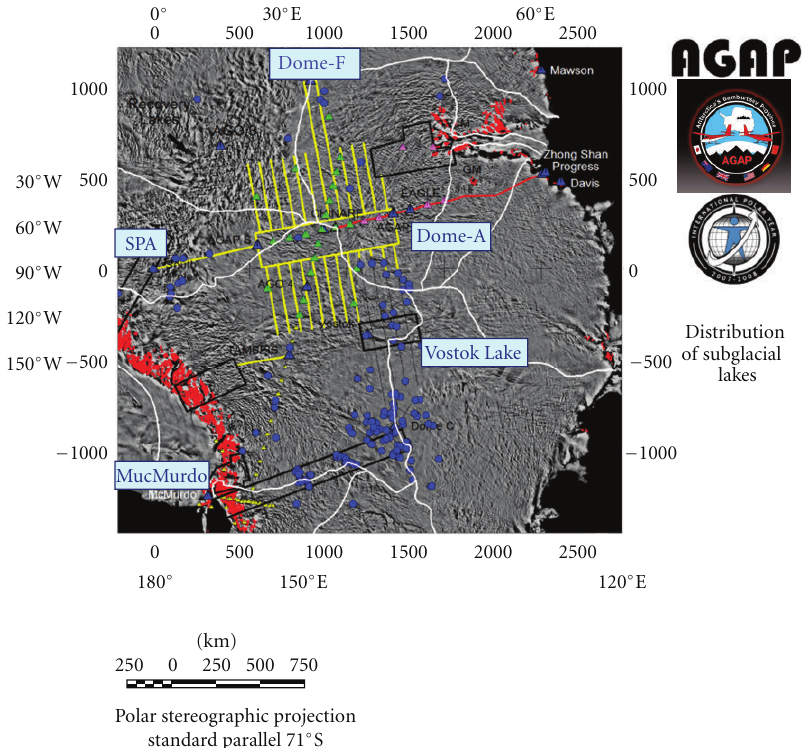
Figure 19: Distribution of subglacial lakes (blue solid circles) in wide region of Wilkes Land, East Antarctica. The target areas for several geophysical surveys including the International Polar Year (IPY 2007–2008) campaign period are demonstrated, by yellow lines (air-borne geophysics by AGAP), red line (Chinese traverse by AGAP), green triangles (seismic stations by AGAP) and several black circulated areas (the other air-borne geophysics projects). (The map is by courtesy of Professors R. Bell and M. Studinger; http://www.ldeo.columbia.edu/ ∼ mstuding/AGAP/). The formation, distribution and stability of subglacial lakes tell us the fundamental question how the tectonic processes control